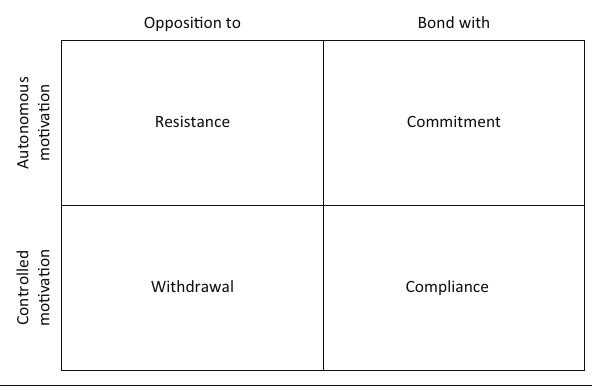
FIGURE 1: Taxonomy of employees’ goal